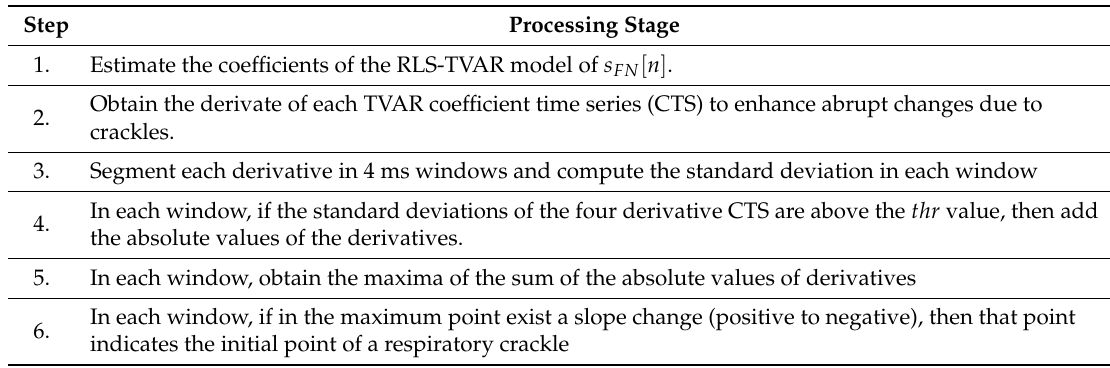
Table 1. Algorithm for automated detection of respiratory crackle sounds.